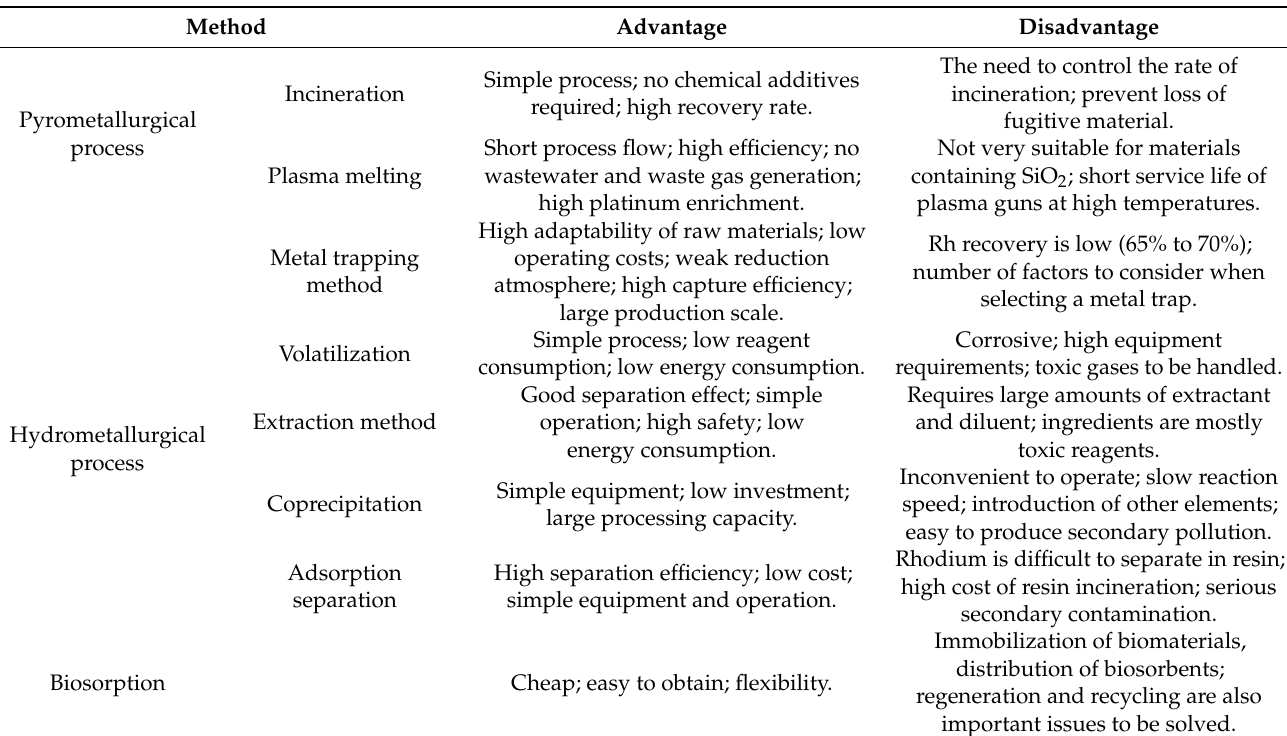
Table 2. Advantages and disadvantages of various recycling